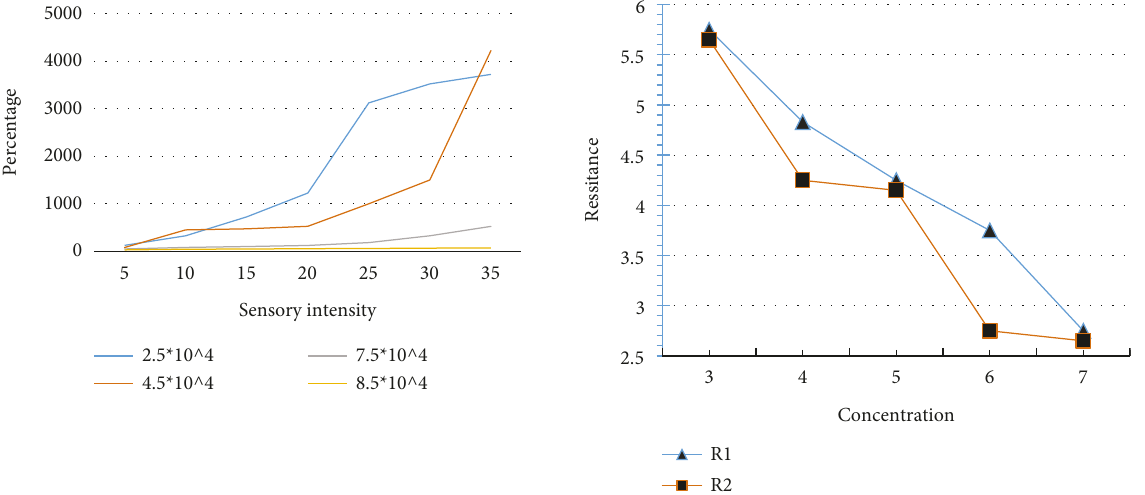
Figure 11: Diagram of the efficiency test of photoelectric